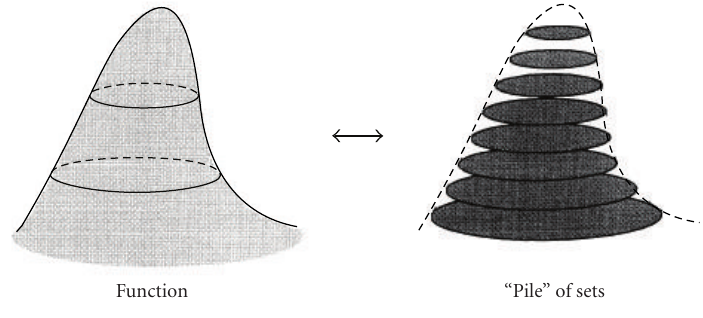
Figure 2.1. Threshold decomposition of a grayscale image (Source: [14].)